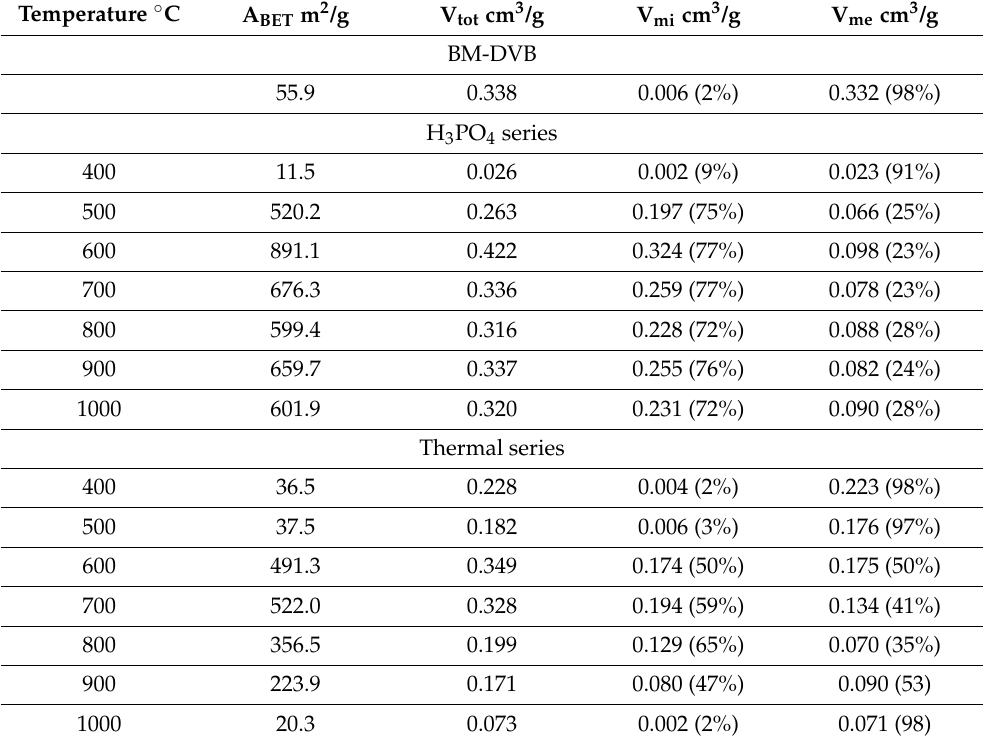
Table 1. Porous structure parameters for parent porous copolymer BM-DVB and polyimide-derived carbons obtained with (H 3 PO 4 -series) and without (Thermal-series) phosphoric acid at different temperatures.